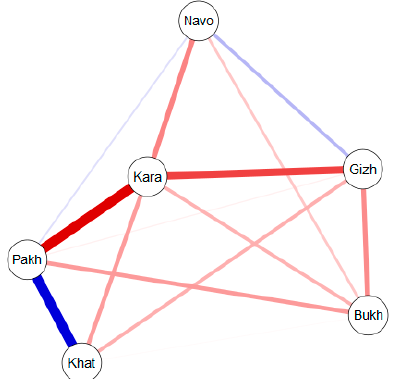
Figure 3. The JASP network plot of the similarity (in R-statistics) of diatom communities from six sites in the Zarafshan River, 2009–2015. The names of sampling sites as in Table 1. The line thickness between sites reflect the correlation value, blue is positive, red is negative.